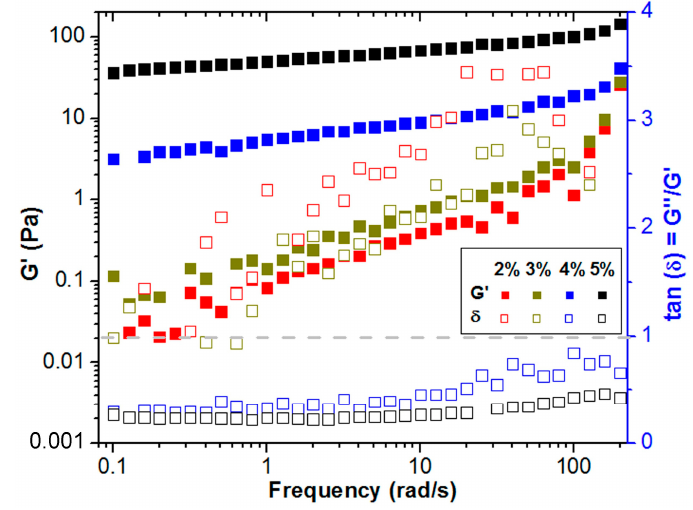
Figure 4. Dependencies of G’ and tan δ (= G” / G’ ) on the frequency at different gelator concentrations. We see a progressive change in the viscoelastic response from a viscoelastic fluid to a solid gel with increasing concentration.